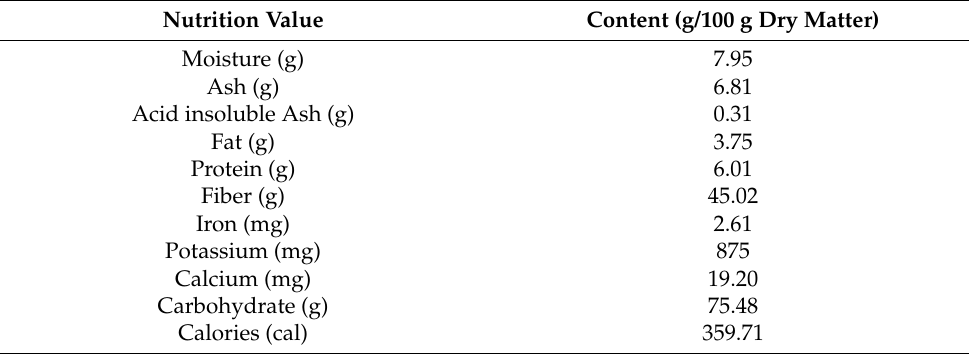
Table 2. Chemical composition of the banana